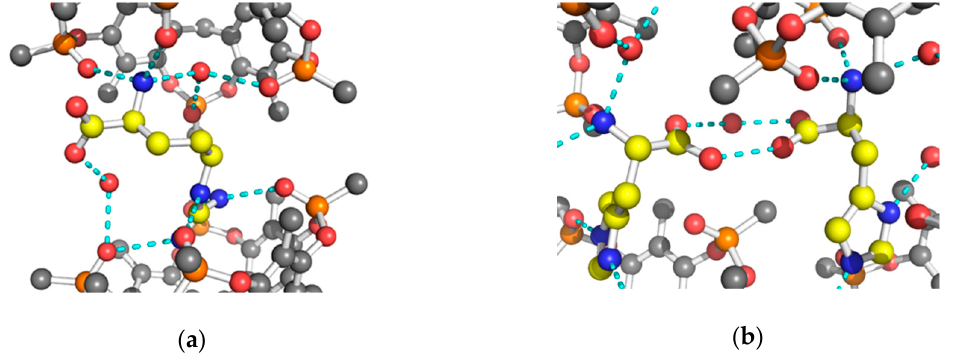
Figure 5. H-bond interactions between the amino acid (yellow carbons) and tetraphosphonate cavitand (gray carbons) ( a ) H-bond interaction between the carboxylic acid group of Arg amino acid and Tiiii mediated by a water molecule (red sphere); ( b ) dimerization of the 2 Tiiii[H, CH 3 , CH 3 ]•His 2HCl complex mediated by a water molecule (red sphere). Hydrogen atoms have been omitted for clarity.